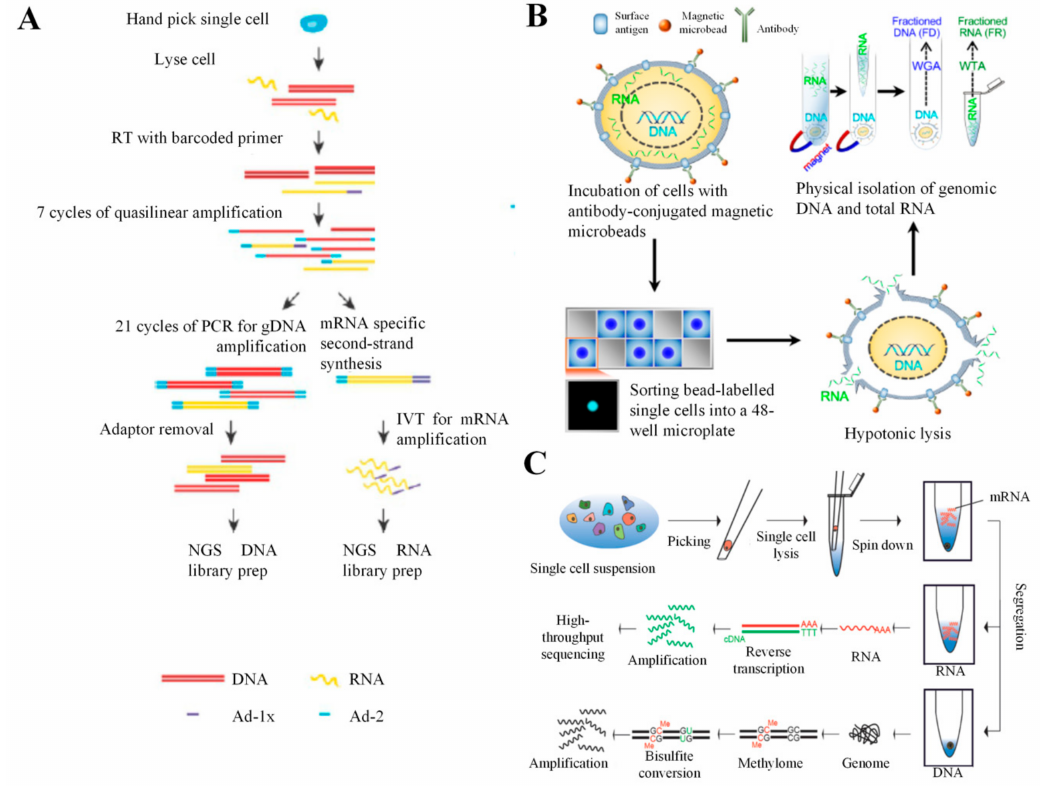
Figure 7. Combination of scRNA-seq with DNA analysis. ( A ) DR-seq permits simultaneous transcriptomic and DNA analysis of the same single cell using a quasilinear amplification strategy. Adapted with permission from Reference [65] Springer Nature (2015). ( B ) SIDR-seq physically separates all RNAs from gDNA, allowing polyadenylated and non-polyadenylated RNAs to be collected for scRNA-seq. Adapted with permission from Reference [67] © Creative Commons Attribution